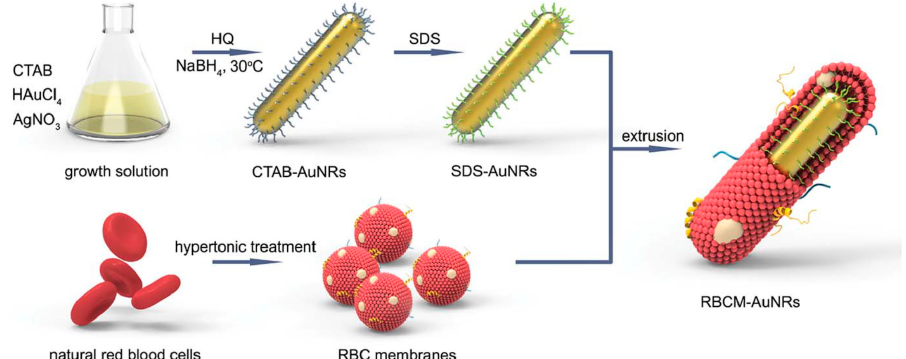
Figure 4. Schematic illustration of the production of the red blood cell membrane camouflaged